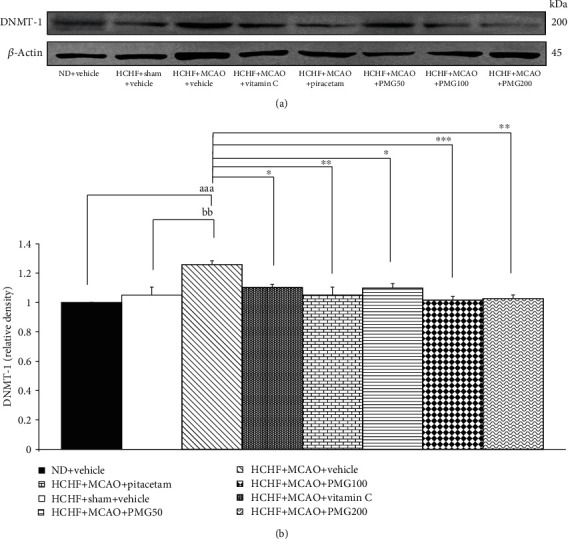
Effect of various doses of PMG on the expression of DNMT-1 in the cerebral cortex was detected by Western blotting. (a) Representative western blot showing the levels of DNMT-1. (b) Relative density of DNMT-1. Data are presented as mean ± SEM (n = 6/group). aaap values < 0.001; compared between naïve control rats which received normal diet and vehicle, and metabolic syndrome+MCAO rats which received HCHF, MCAO, and vehicle, bbp values < 0.01; compared between sham rats which received HCHF, sham operation, and vehicle, and metabolic syndrome+MCAO rats which received HCHF, MCAO, and vehicle and ∗, ∗∗, ∗∗∗p values < 0.05, 0.01, and 0.001, respectively; compared to metabolic syndrome+MCAO rats which received HCHF, MCAO, and vehicle. ND: normal diet; HCHF: high-carbohydrate high-fat diet; MCAO: middle cerebral artery occlusion; vitamin C: the vitamin C at a dose of 250 mg.kg−1 BW; piracetam: the piracetam at a dose of 250 mg.kg−1 BW; PMG 50, PMG 100, and PMG 200: the phytosome containing the combined extract of mulberry fruit and ginger at doses of 50, 100, and 200 mg.kg−1 BW, respectively.